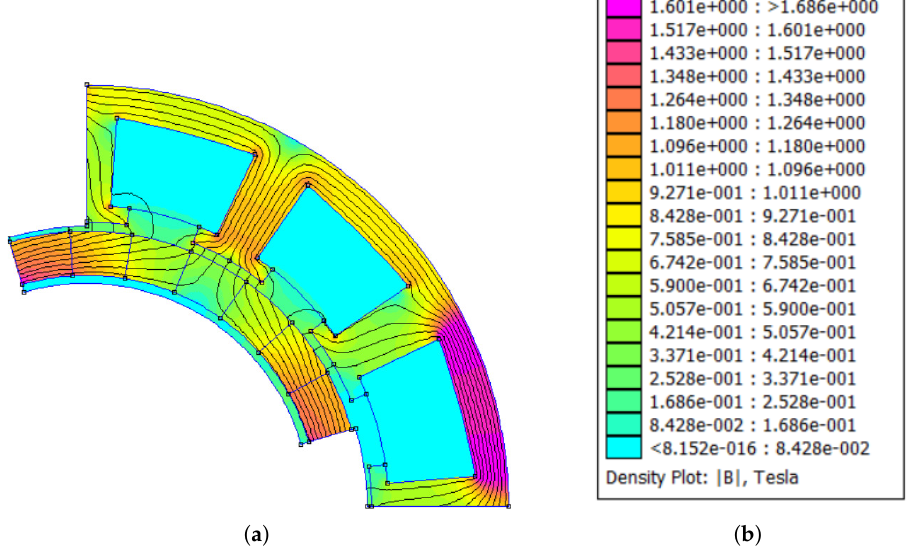
Figure 9. Distribution of flux density in the active parts of the motor ( a ), and Density Plot ( b ).